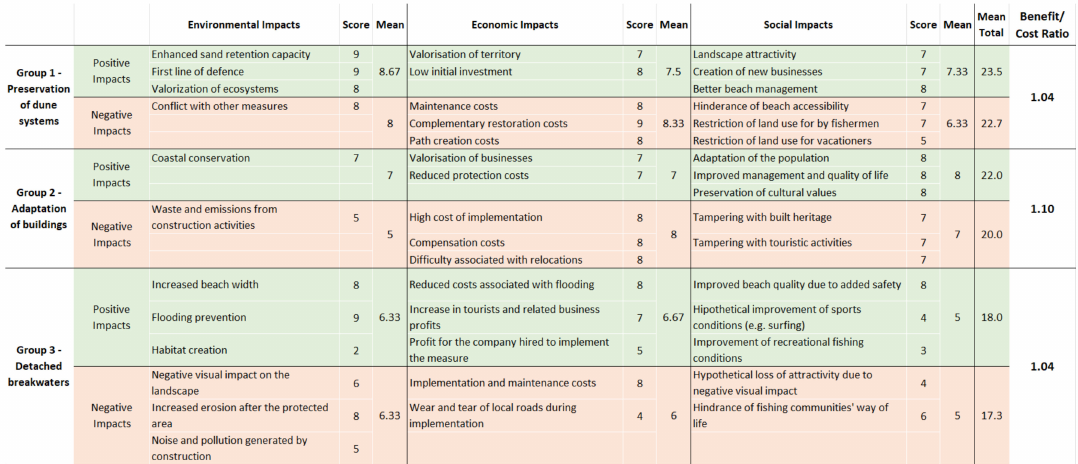
Figure 3. Results of the cost–benefit analysis performed by the three work